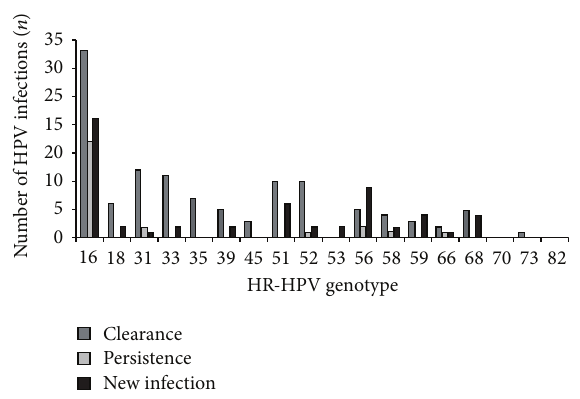
Figure 4: Ninety-eight women treated by LLETZ for CIN2+ had liquid base cytology samples taken before and after treatment for HPV testing. The number of HR-HPV infections that were cleared are indicated in dark grey, the infections that persisted after treat- ment are indicated in light grey, and all new infections are shown in black